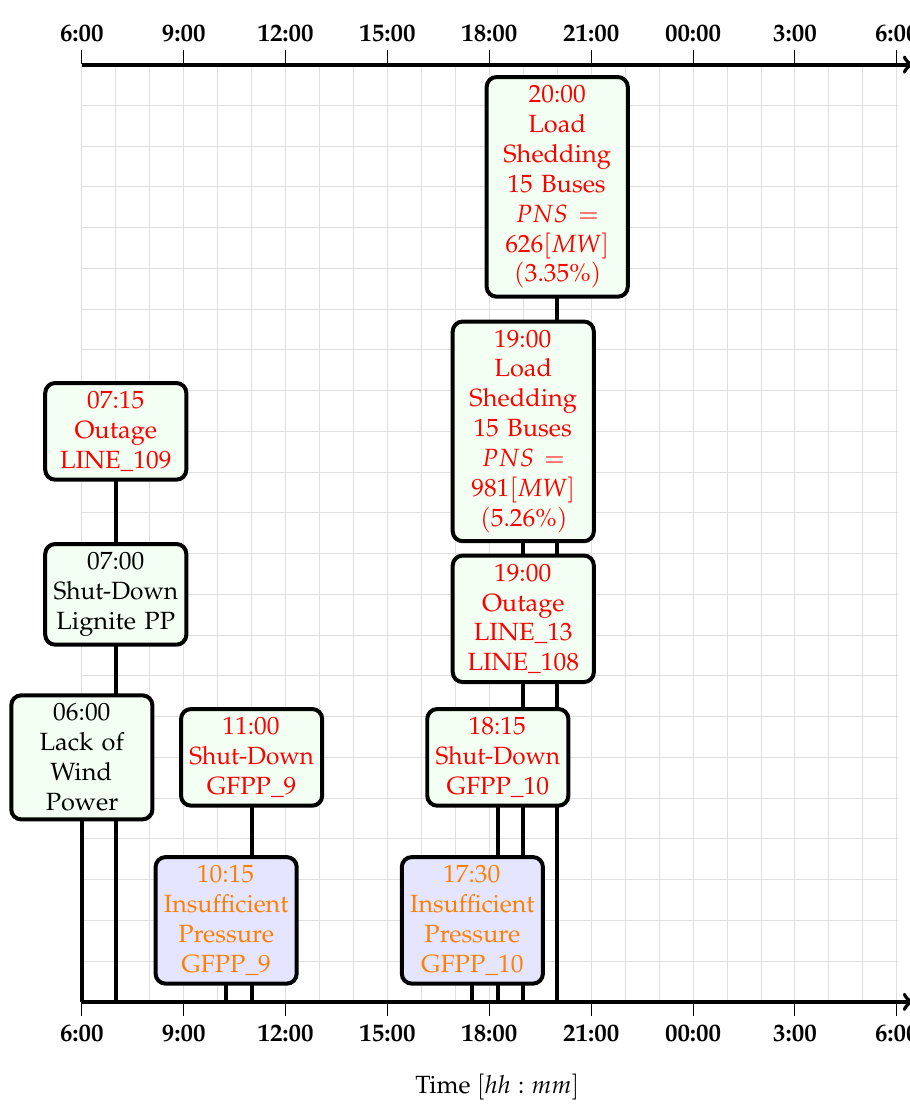
Figure 7. Timing of initial ( black ) and cascading ( orange , red ) events for Scenario 2. Abbreviation PNS stands for power not supplied, value in brackets refers to the fraction of not supplied power with respect to total